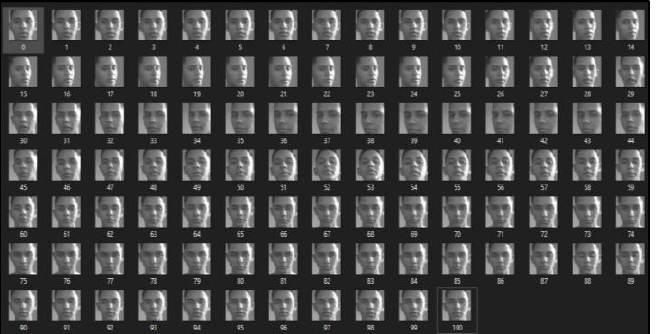
Figure 25: Trainee's clocking register screen.